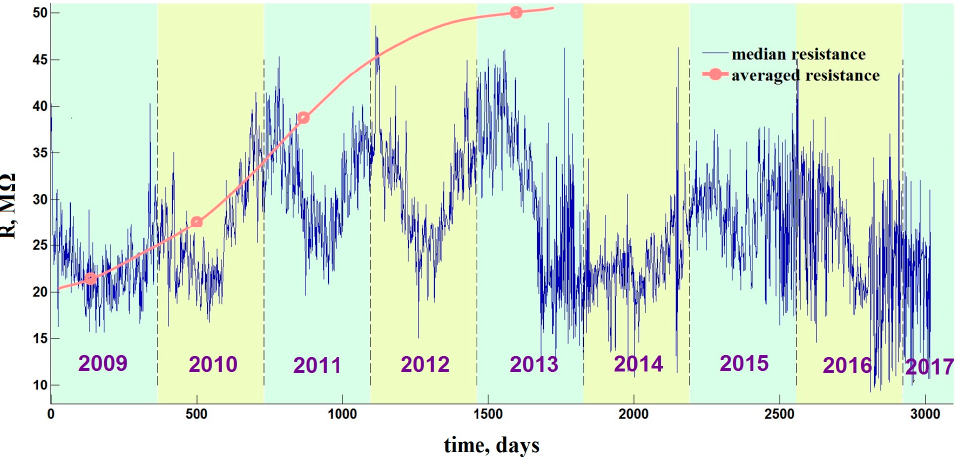
Figure 11. The long-term evolution of median sensor resistance of the array in the e-nose measured from 2009–2017. The median evolution expresses the year-season and short-term variations. The averaged resistance represents the mean value of few typical sensor segments #22–25 from the array; points correspond to the distributions given in Figure 10 to be fit by curve built by their polynomial approximation. The averaged points illustrate the long-term drift and the eventual stabilization of sensor resistances. Oscillations of the curve to be seen since the fourth quarter of 2015 are reasoned by jumping of the position of median from one segment to another.